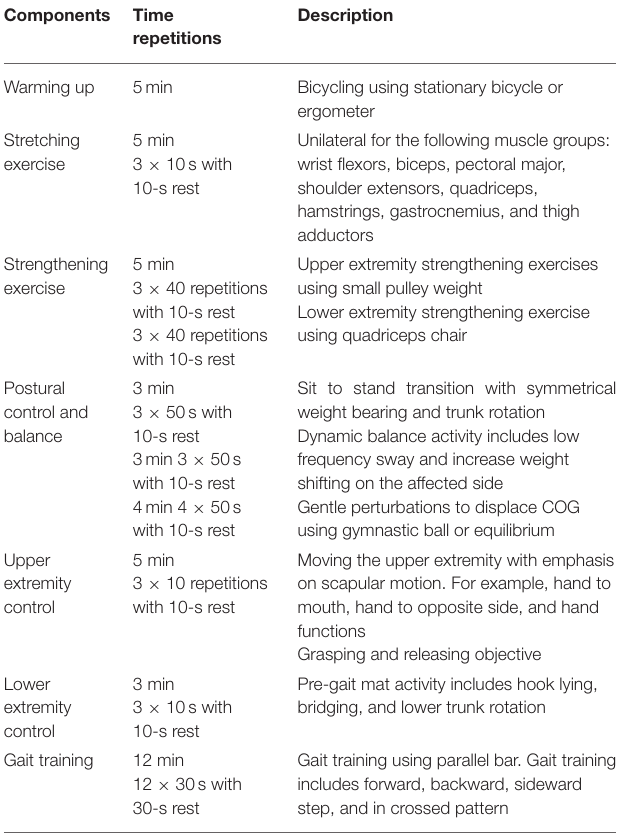
TABLE 1 | Description of conventional rehabilitation program